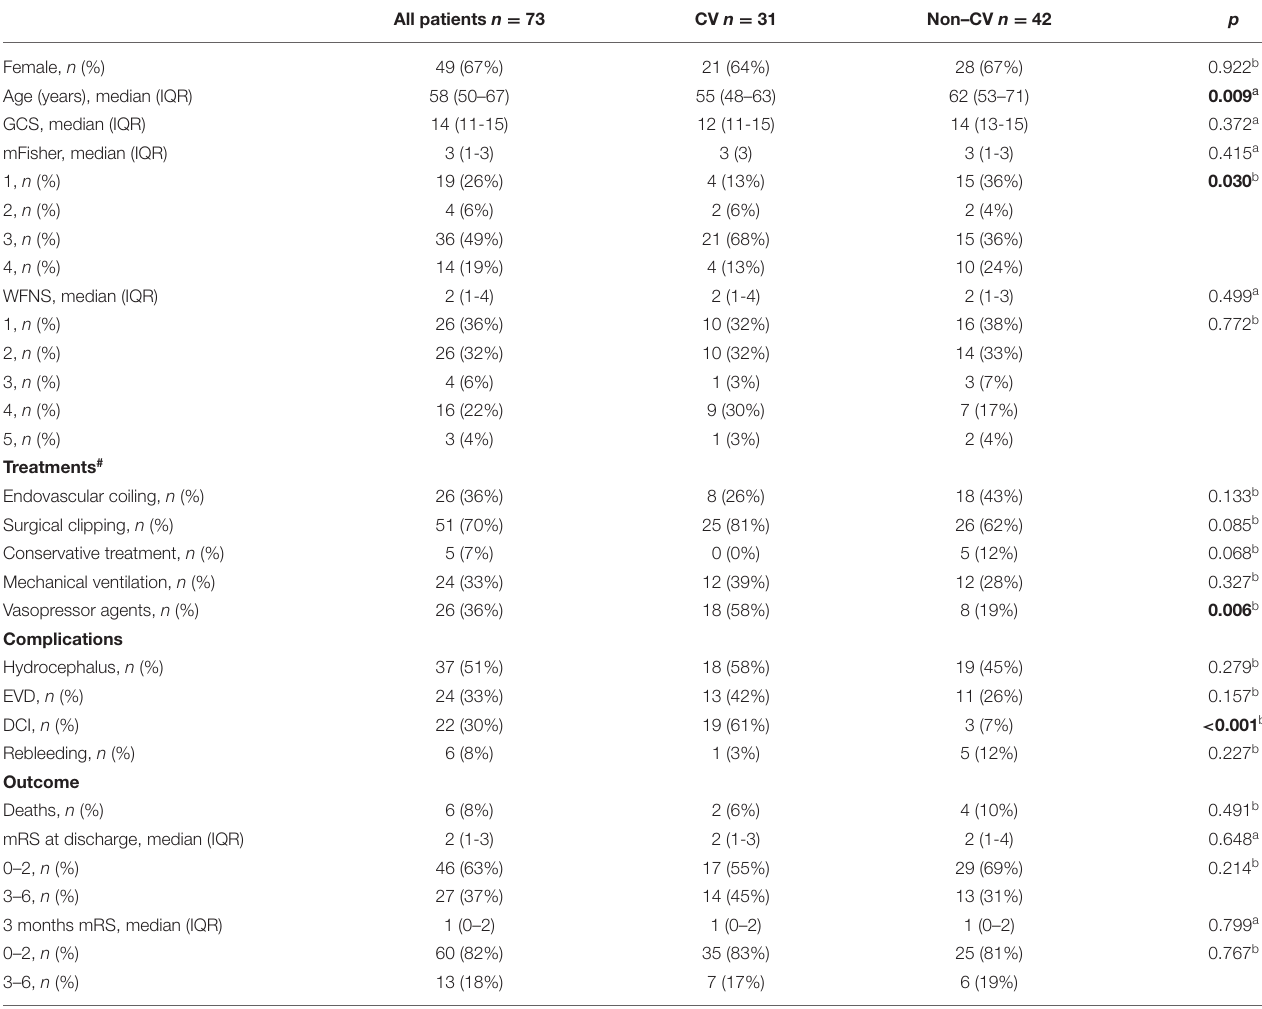
TABLE 1 | Patient